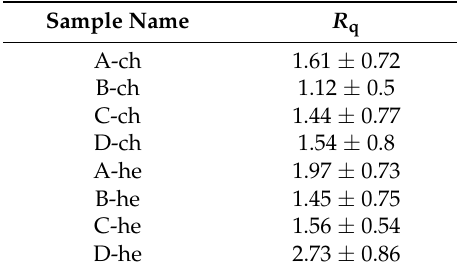
Figure 6. The AFM images of TiO 2 NRs deposited by spray coating on the silicon substrates. The samples were prepared from a 0.02 M chloroform solution of TiO 2 NRs with a spraying time of 1 min Sample A-ch ( a ); 1 min 30 s, sample B-ch ( b ); 2 min, sample C-ch ( c ); 2 min 30 s sample D-ch ( d ), respectively. The second set of samples was prepared from a 0.02 M solution of TiO 2 NRs dispersed in n-heptane with a spraying time of 1 min, sample A-he ( e ); 1 min 30 s sample B-he ( f ); 2 min, sample C-he ( g ); 2 min 30 s, sample D-he ( h ), respectively. Table 2. The roughness values ( R q ) of silicon substrates treated with TiO 2 NRs from chloroform and n-heptane dispersions obtained for different spraying